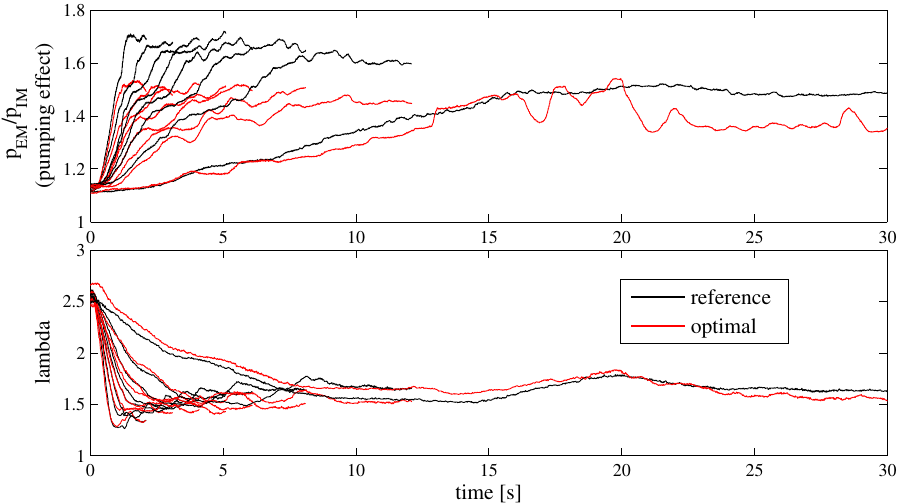
Table 4. Sensitivity analysis of the optimization framework, analyzed for three cases representing fast, medium and very slow ramps. Arrows indicate the NO qualitative